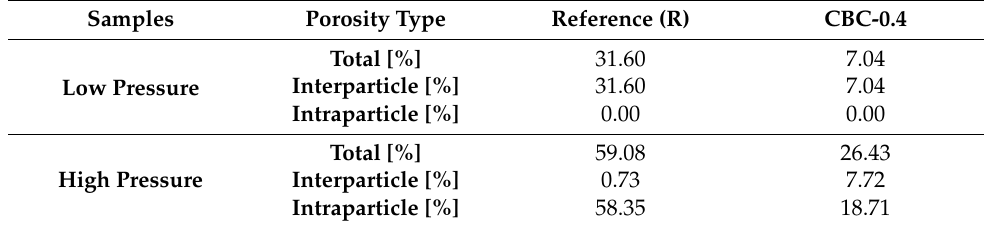
Table 8: Table 8. Mercury intrusion porosimetry tests